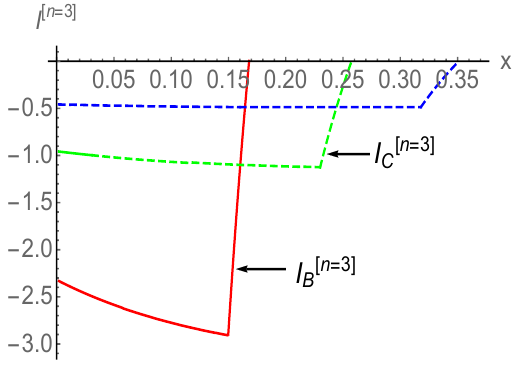
Figure 13 . I [ n =3] for S B and S C phases as a function of x . The solid lines correspond to I [ n =3] whereas the dashed lines corresponds to B I [ n =3] . The red, green and blue lines correspond C to strip length ‘ = 0 : 2, 0 : 3 and 0 : 4 respectively. In units